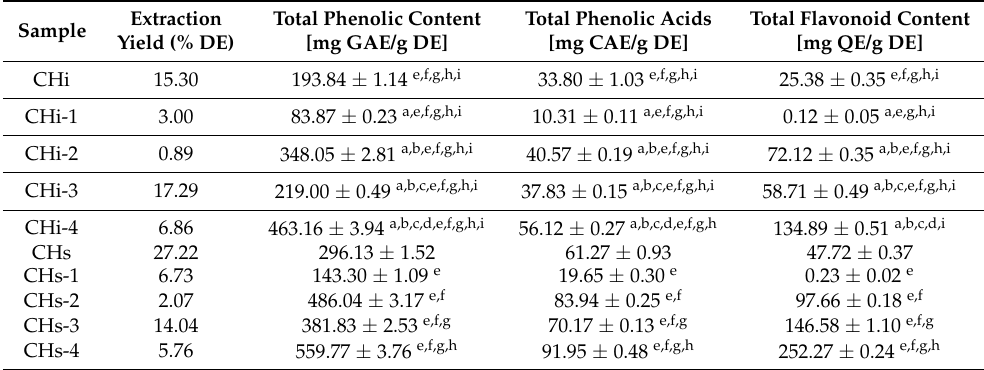
C. hissaricus and C. hsingshangensis leaf